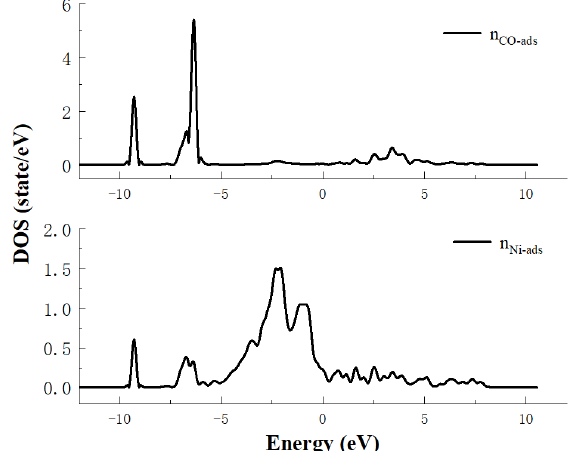
Energies 2023 , 16 , x FOR PEER REVIEW Figure 8. Comparison of the density of the states of a CO molecule and a Ni atom after adsorption. The adsorption of CO molecules on the Ni crystal face leads to a change in their elec- tronic states. In order to confirm their orbital compositions, the density of the state image is divided according to the different orbitals based on Figure 8 to obtain the atomic orbital density of the state images of carbon, oxygen and nickel atoms. Figure 9 shows the density of the states of the different orbitals of carbon, oxygen and nickel atoms after adsorption. Based on the results shown in the graphics, the hybridization of CO molecules and Ni atoms in an energy range of − 10 eV~ − 8 eV mainly comes from the hybridization of the s orbitals of the carbon atom and the s and p z orbitals of the oxygen atom with the s, p and d orbitals of the nickel atom. In an energy range of − 7.5 eV~ − 6 eV, the surface adsorption of both produces hybridization mainly due to the hybridization of the p x and p y orbitals of carbon and oxygen atoms with the s and d orbitals of nickel atoms. The hybridization phenomenon in the energy range of 2 eV–5 eV arises mainly due to the hybridization of the p x and p y orbitals of carbon atoms with the p and d orbitals of nickel atoms.